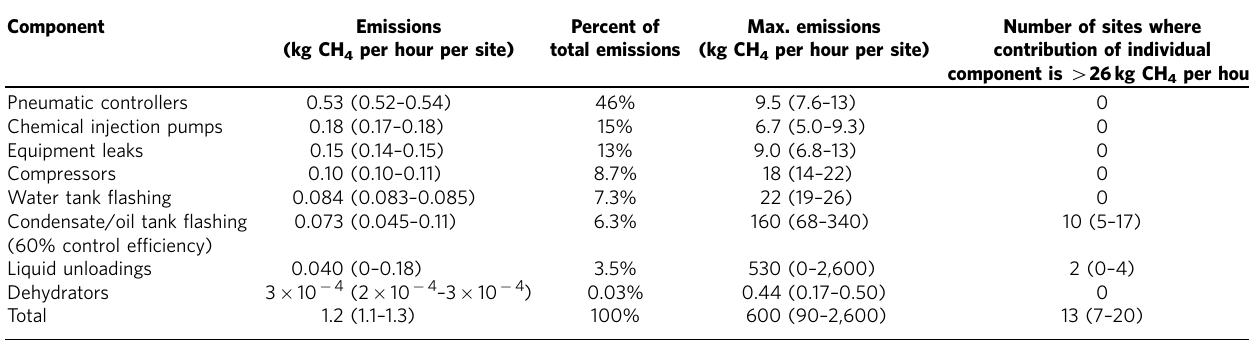
Table 1 | Results of Monte Carlo aggregation of component-based emissions in the Barnett Shale.